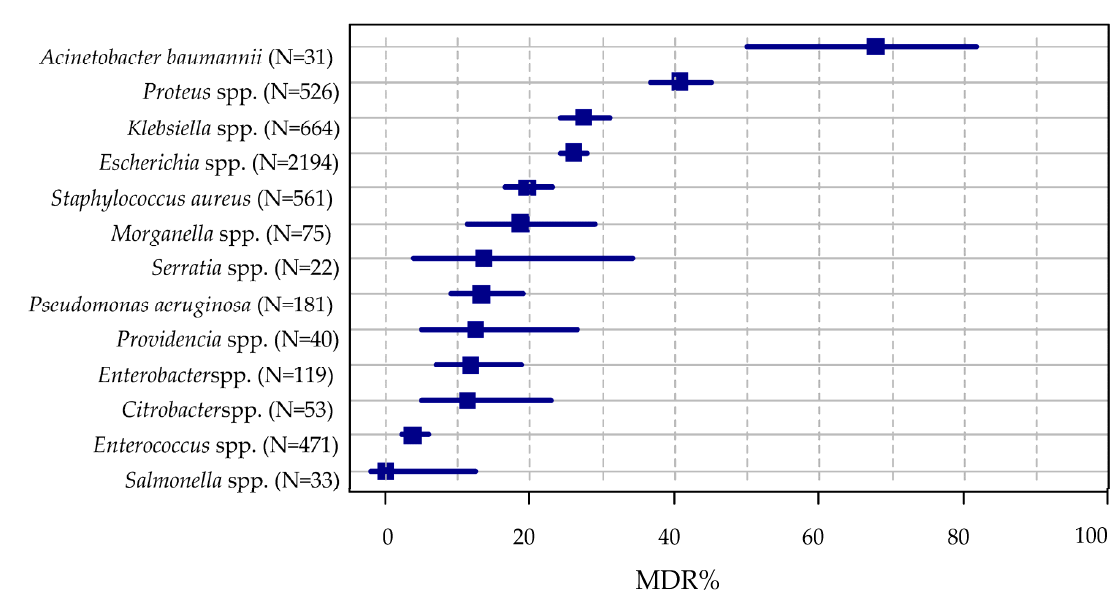
Figure 1. Rate of multi-drug resistance among ESKAPE isolates.